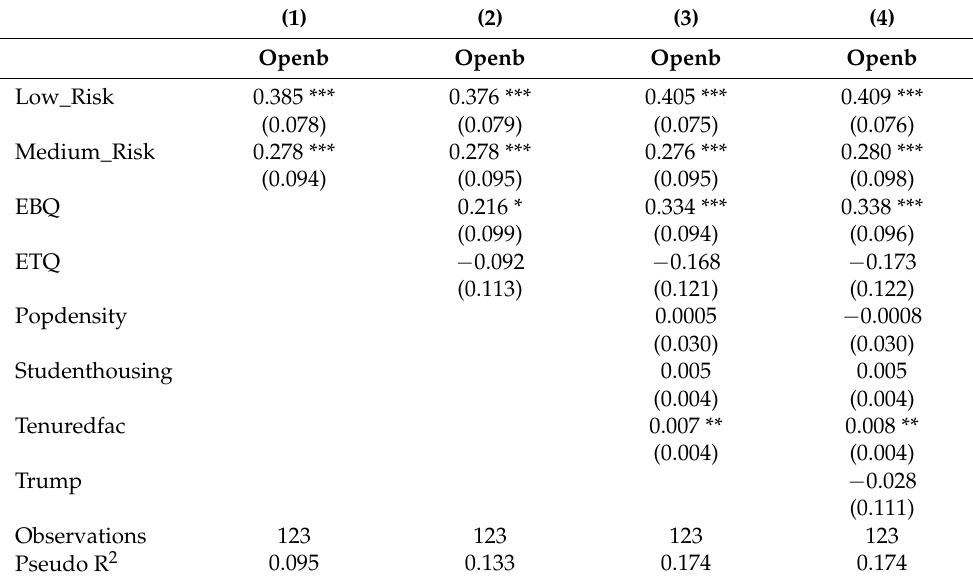
Table 3. Probit Models Using Endowment per Student Quartiles (Marginal